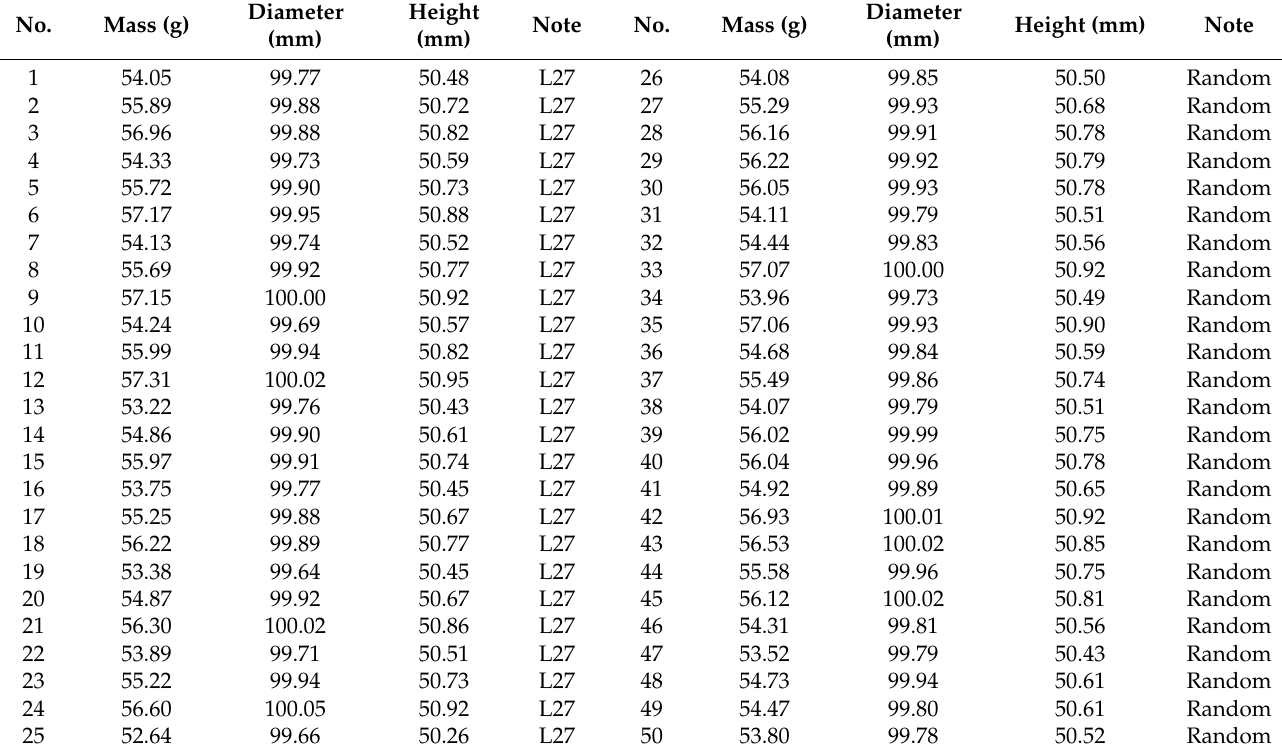
Table A1. Product qualities for injection molding conditions with linearity.